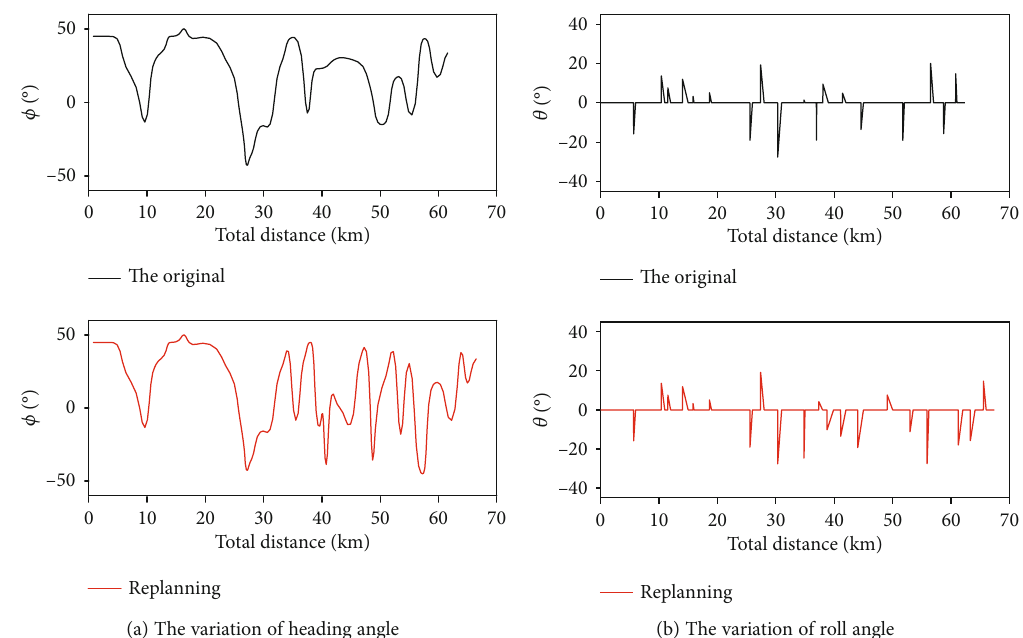
Figure 6: The variation of attitude angle that performed by improved A-Star algorithm in the fi rst scenario.